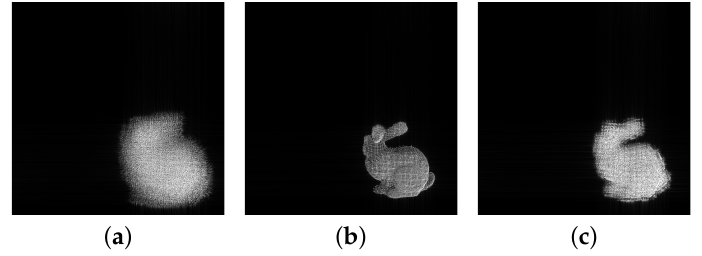
Figure 2. Result of Fresnel transform to hologram ( a ) 70 cm, ( b ) 100 cm, ( c ) 150